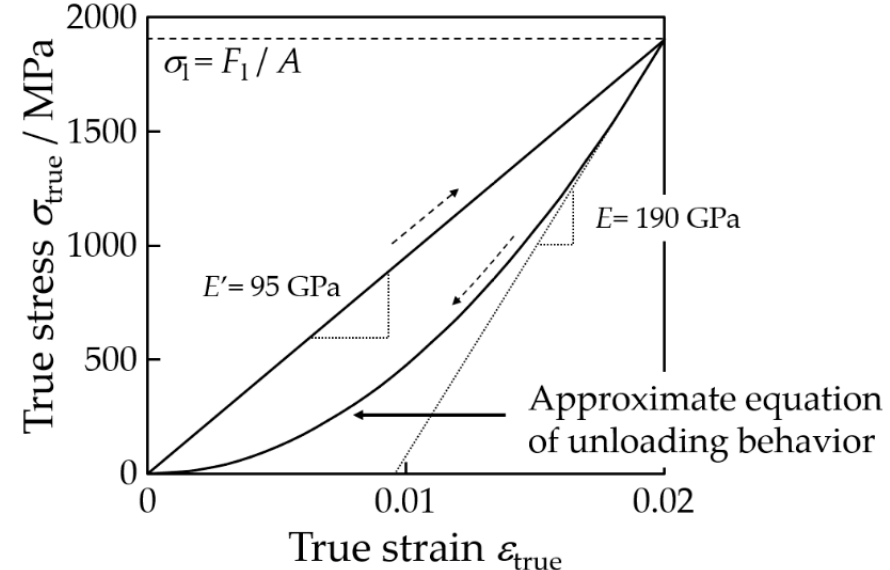
Figure 24. Unloading behavior when the true strain completely recovers. The parameter σ l is the drawing stress. The parameters F l and A are the drawing force and the cross-sectional area of the drawn tube, respectively. The parameters E and E ’ are the elastic modulus of the bulk metal and apparent elastic modulus, respectively.